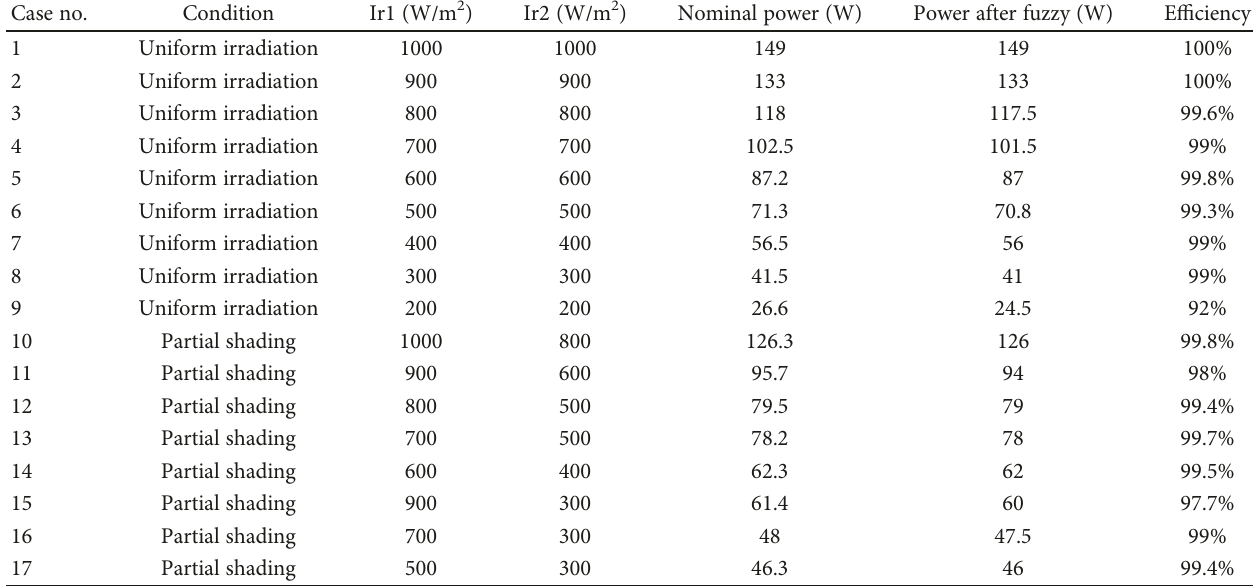
Table 4: Values of model outputs.